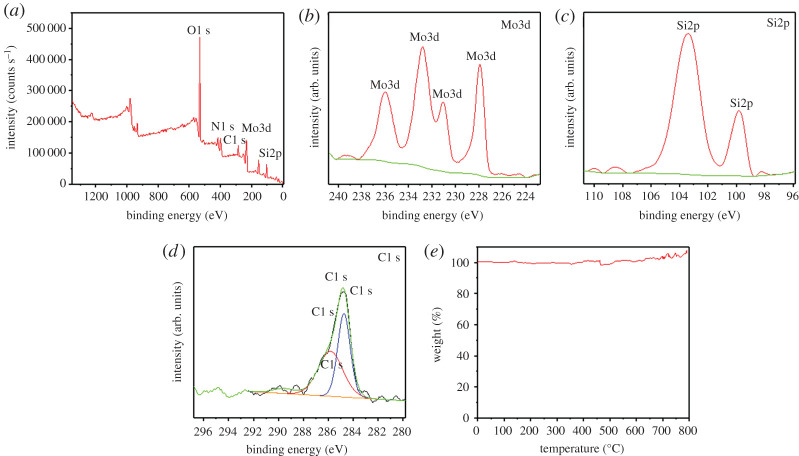
(a–d) XPS spectra of MoSi2 ceramic, (e) TGA of MoSi2 ceramic.